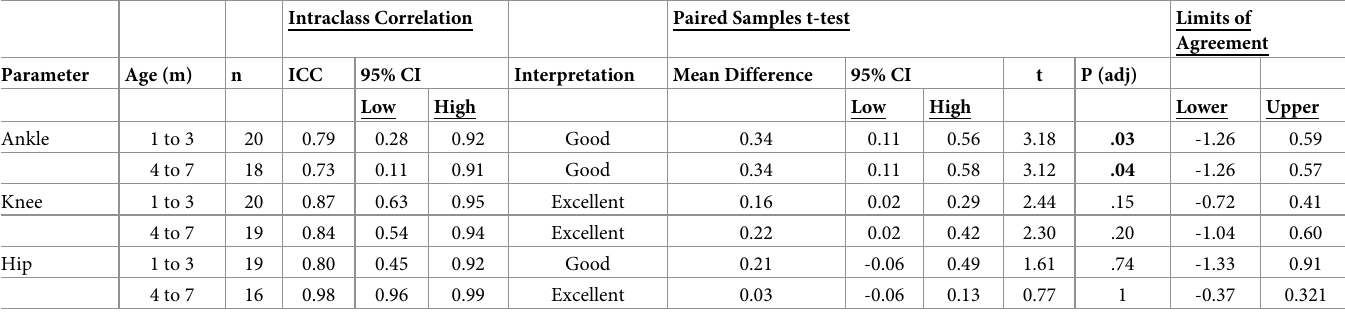
Table 2. Agreement analysis of ‘single trial’ and ‘average of all trial’ summary measures in control subjects separated by age group. Intraclass